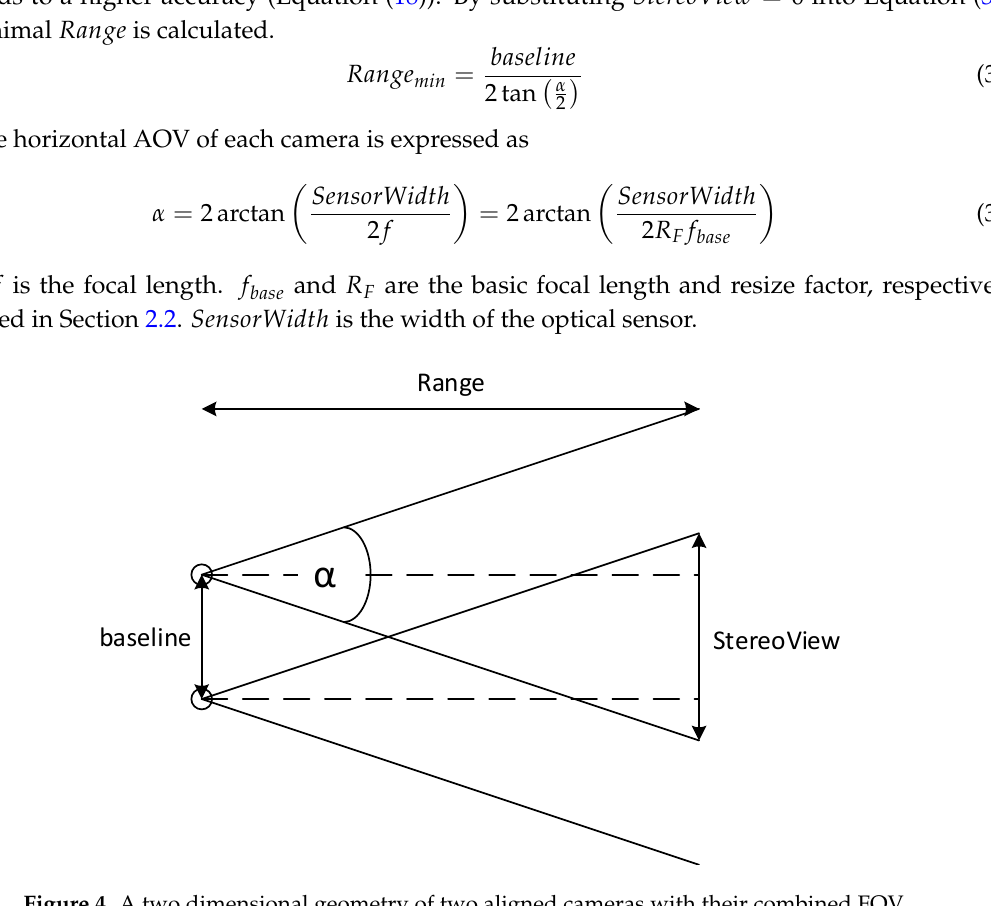
Figure 4. A two dimensional geometry of two aligned cameras with their combined FOV.